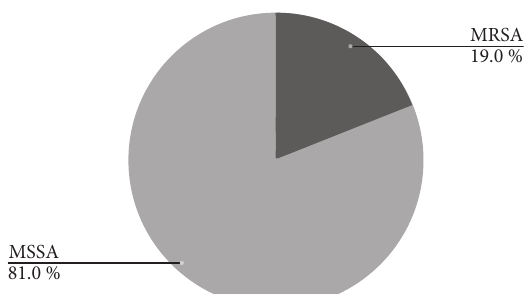
Figure 5: Occurrence of MRSA and MSSA in the environment sample.